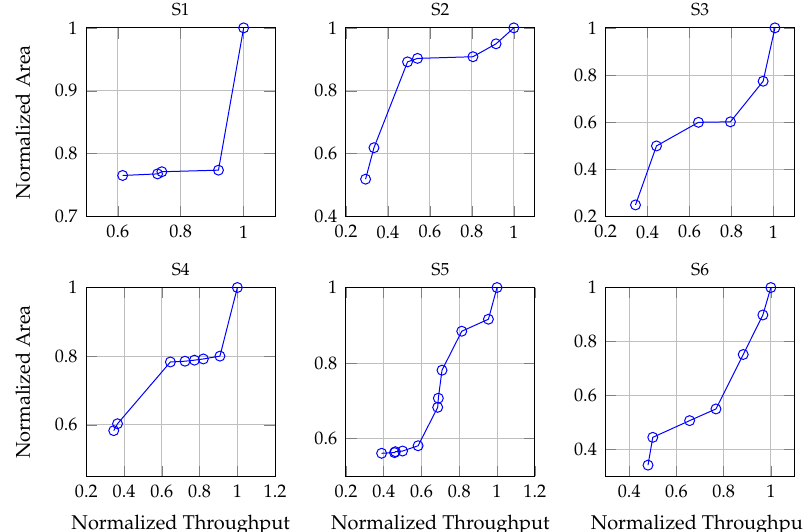
Figure 9. System exploration trade-off